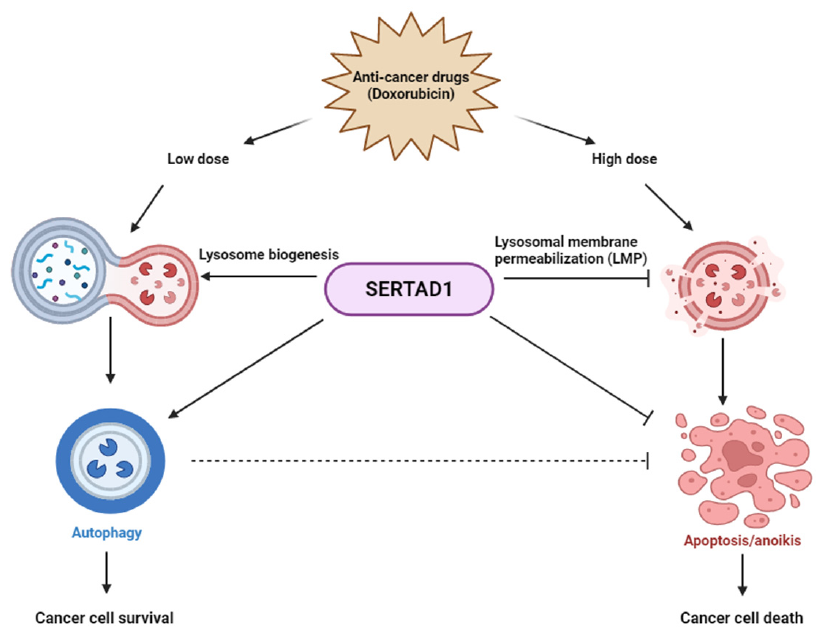
Figure 6. Summary model. SERTAD1 sensitizes cancer cells to anti-cancer drugs and affects lysosome biogenesis and LMP.